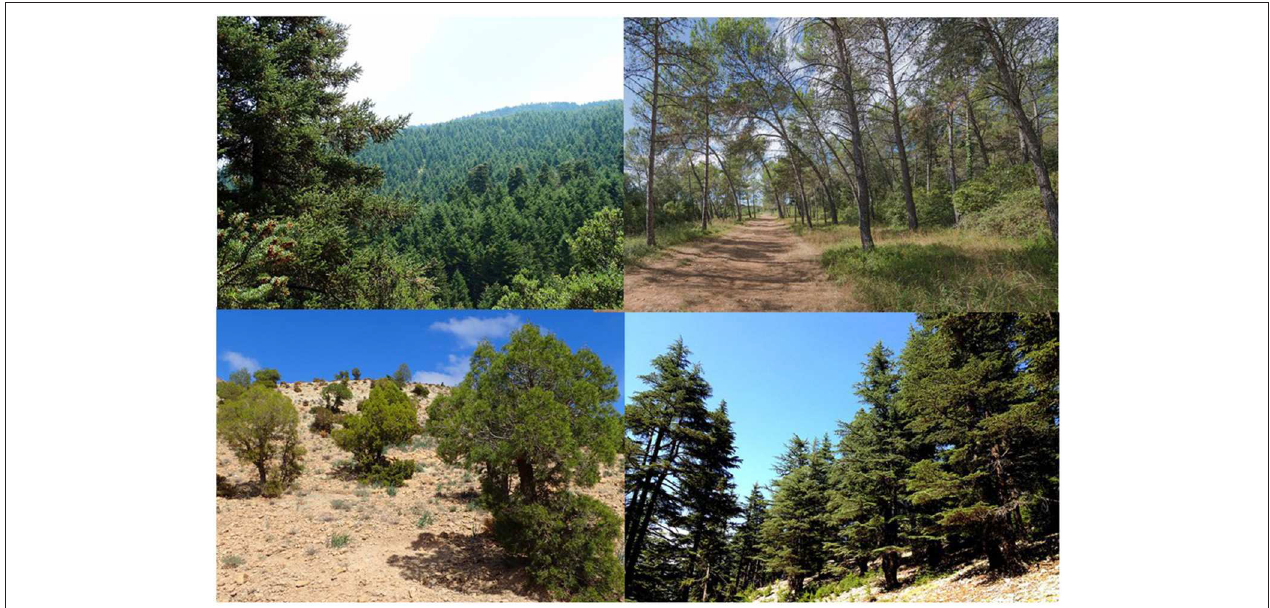
FIGURE 4 | Endemic conifers of the Mediterranean Basin. Abies cephalonica , Pinaceae (photo by Jim Boun); Pinus halepensis , Pinaceae (photo by Christian Ferrer), Tetraclinis articulata , Cupressaceae (photo by Kenraiz); Cedrus libani , Cupressaceae (photo by Zeynel